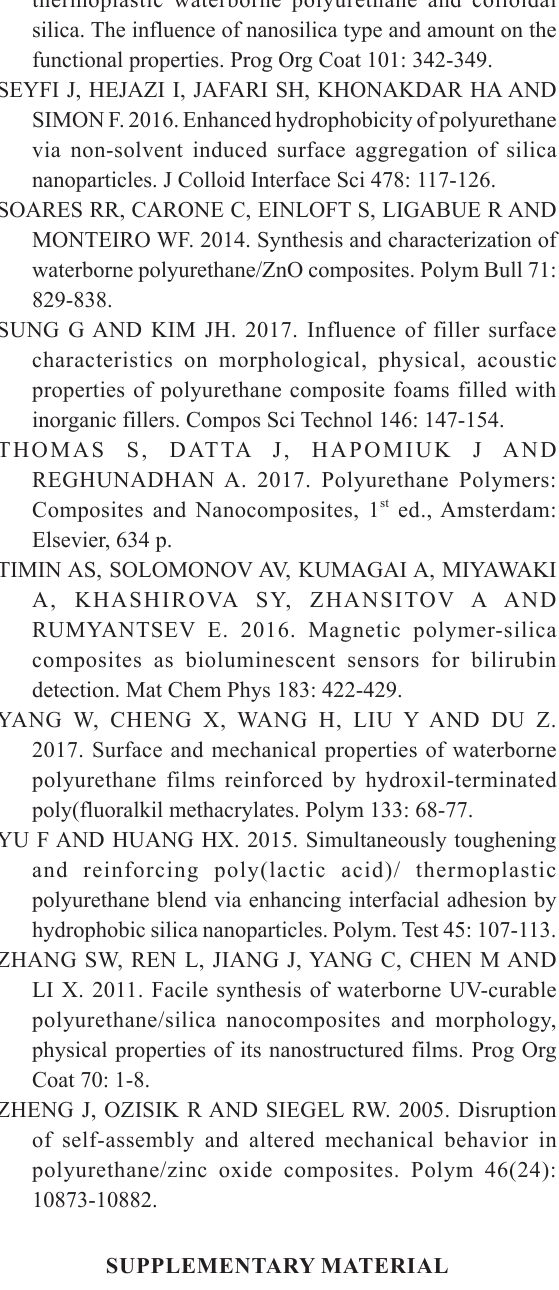
Figure S1 - SEM images of the SiO2 filler (a) 60x and (b) 100000x. Figure S2 - Results of (a,c) TGA and DTG of CP1; (c,d) TGA and DTG of